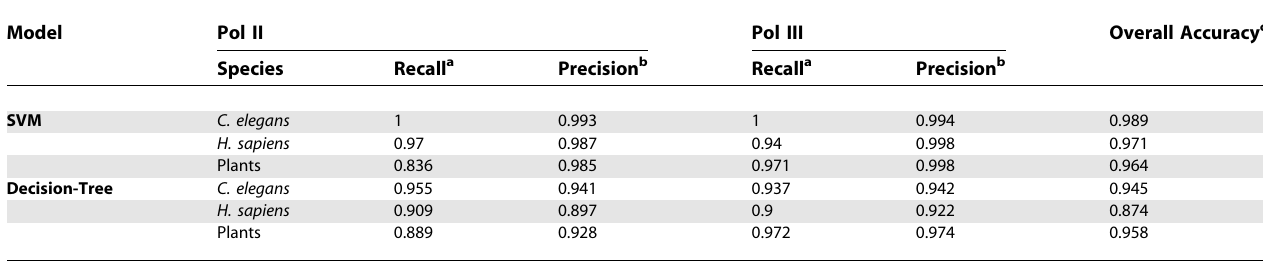
Table 4. Results of 10-Fold Cross-Validations of SVM and Decision-Tree Models